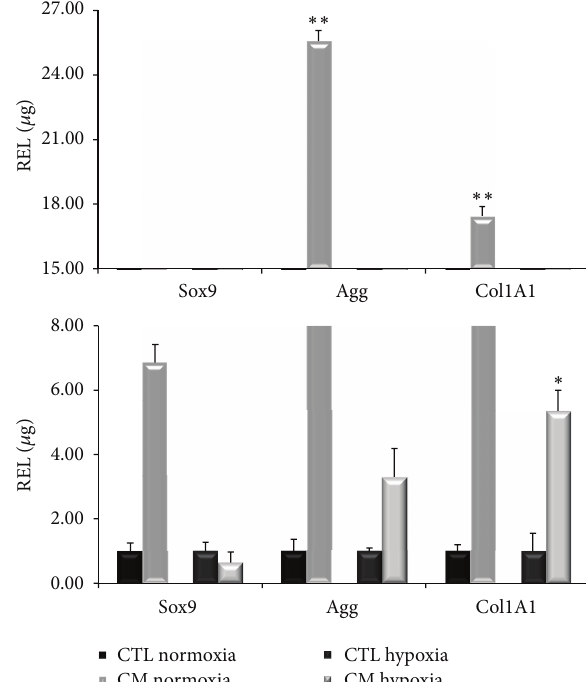
Figure5:Chondrogenic-specificgeneexpressionlevelsinnormoxic and hypoxic conditions. In these figures we compared control points (CTL) and treated cells (CM). Expression levels of Sox9, Agg, and Col1A1 at day 14 of cultures in normoxic conditions ( ∗∗ 𝑃 < 0.005 ) and in hypoxic conditions ( ∗ 𝑃 < 0.05